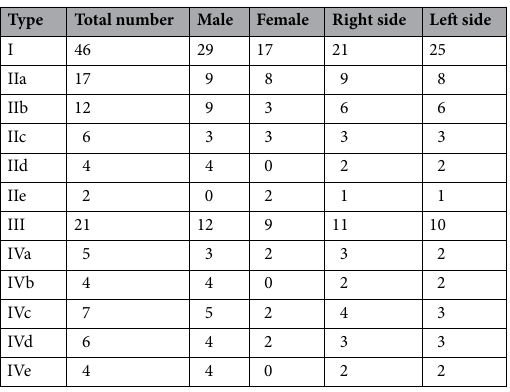
Table 1. The number of specified types depends on the sex and the side of the